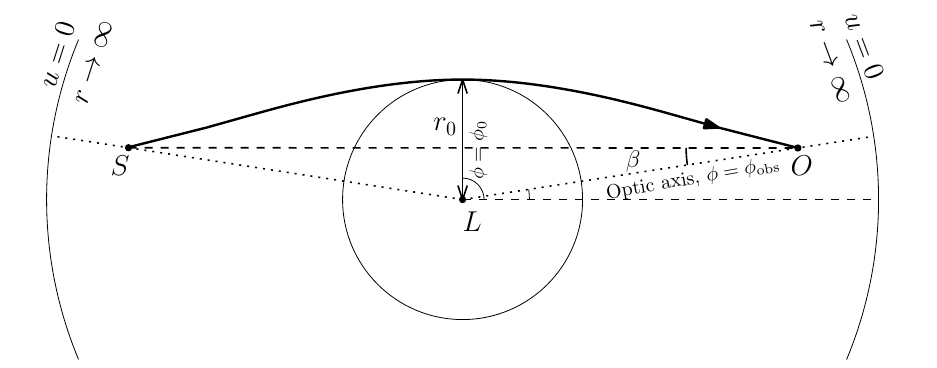
Figure 1. The trajectory of light from source S to observer O , passing at a distance of closest approach r 0 to the lens L . The asymptotic region r is represented by the outer circular arcs. We assume → ∞ the trajectory does not cross either the cosmological or event horizons of the spacetime. Here we have drawn the angles φ 0 and φ obs to be relative to the horizontal dashed line, implying that this horizontal line is the φ = 0 angle. However this is clearly an arbitrary choice and does not a ff ect the analysis.